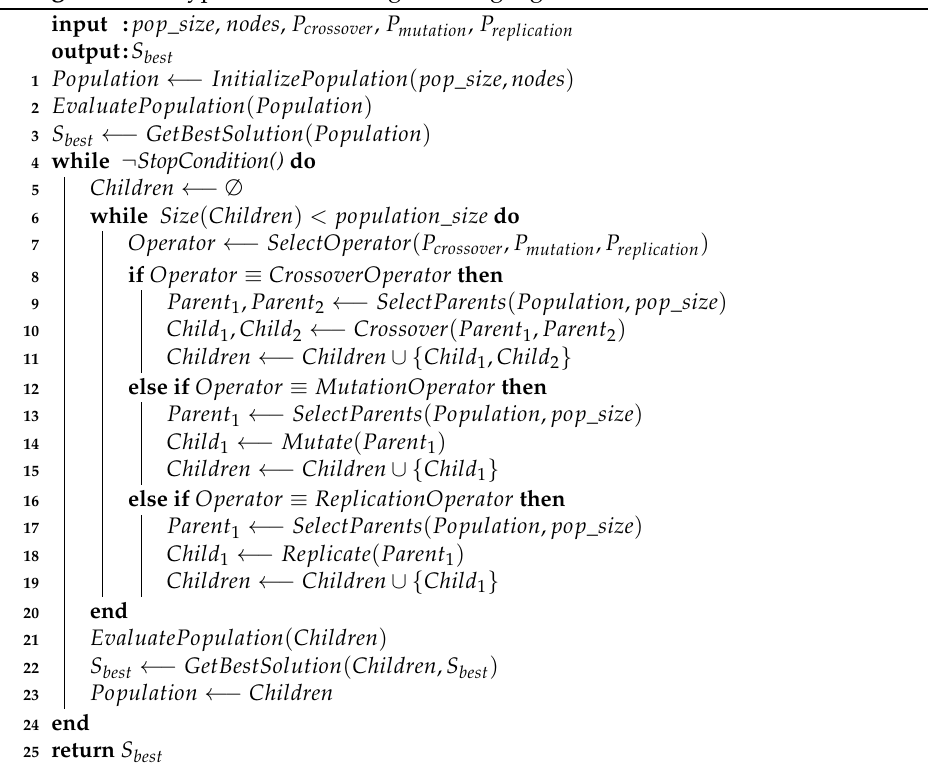
Algorithm 1: Typical Genetic Programming